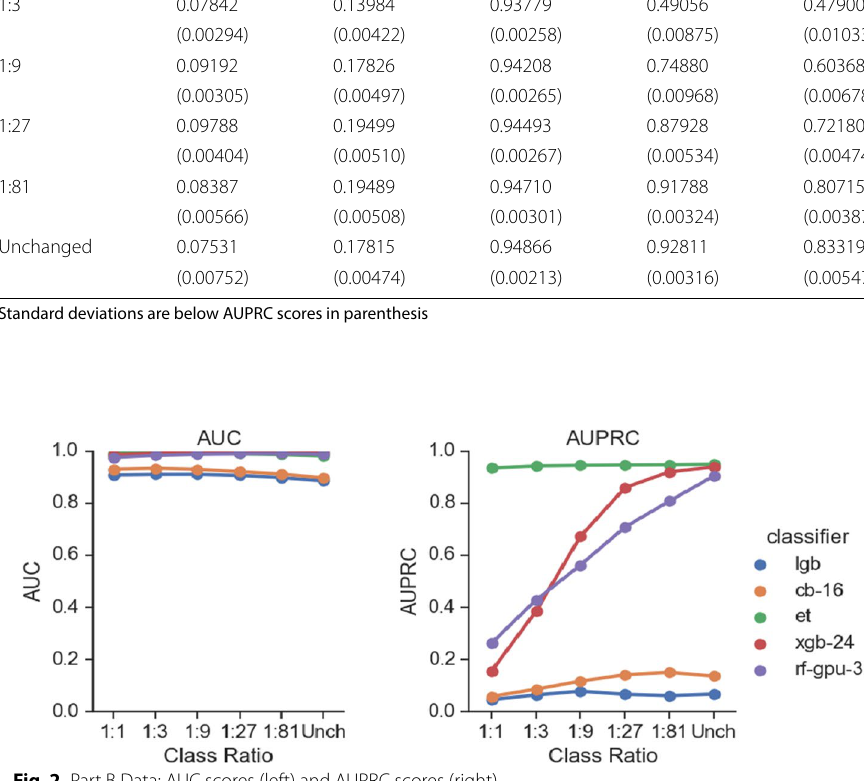
Fig. 2 Part B Data: AUC scores (left) and AUPRC scores (right)